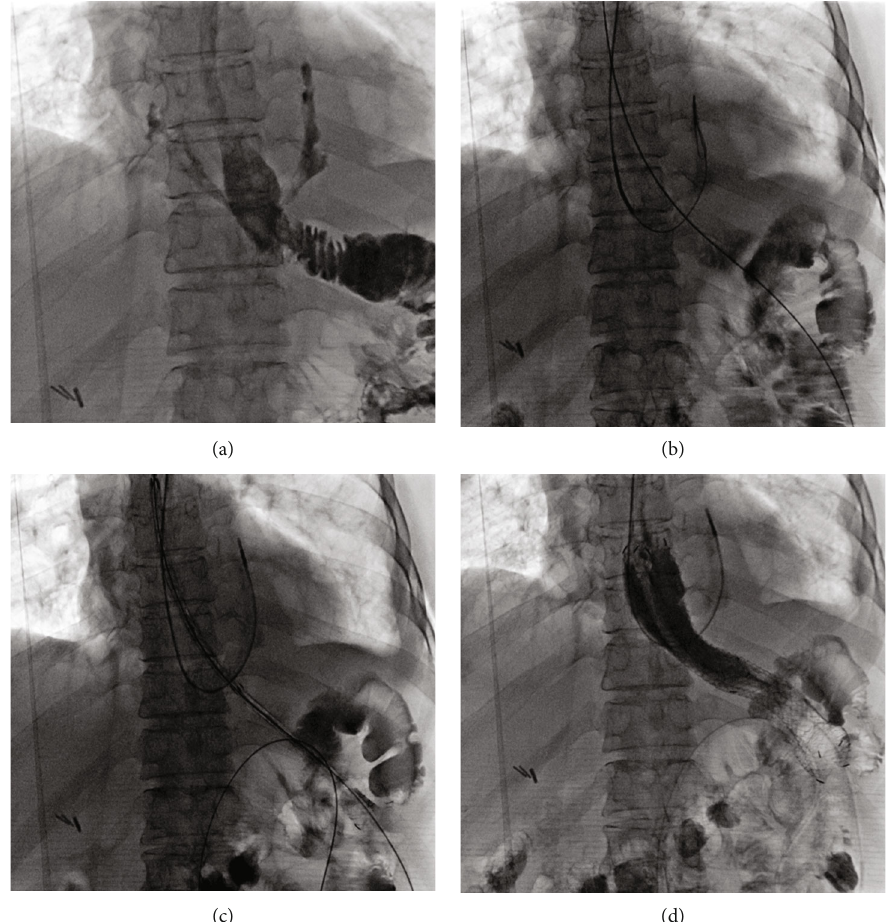
Figure 2: A 65-year-old woman with anastomotic leakage (case 16). (a) Esophagography showing the site of anastomotic leakage in the lower esophagus. (b) A 5F catheter was introduced through the outlet of leakage into the distal end of the abscess cavity. (c) A stent delivery system was introduced along the sti ff guidewire. (d) Esophagography showed that the contrast agent fl owed through the stent with no leakage after esophageal